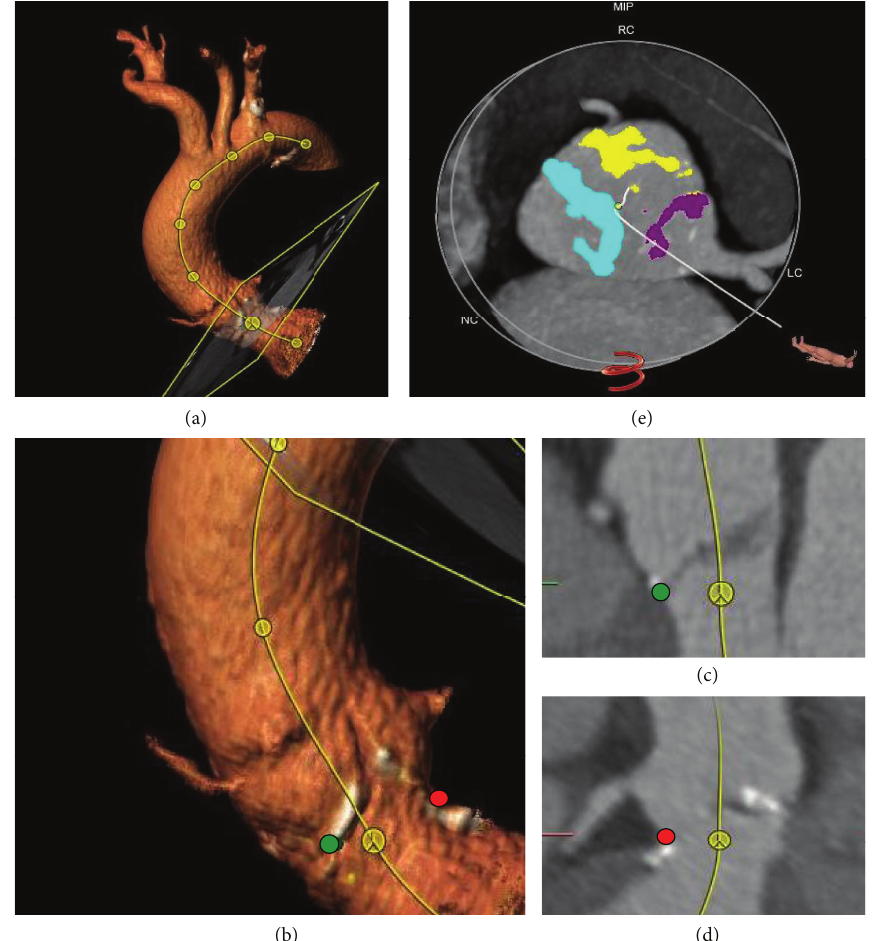
Figure 1: Multidetector computed tomography (MDCT) analysis illustrating calcification measurements. (a) Centerline of the aortic root and the ascending aorta. (b), (c), and (d) Anchor points at the level of the insertion of the aortic leaflets. (e) Measurement of calcification volume and